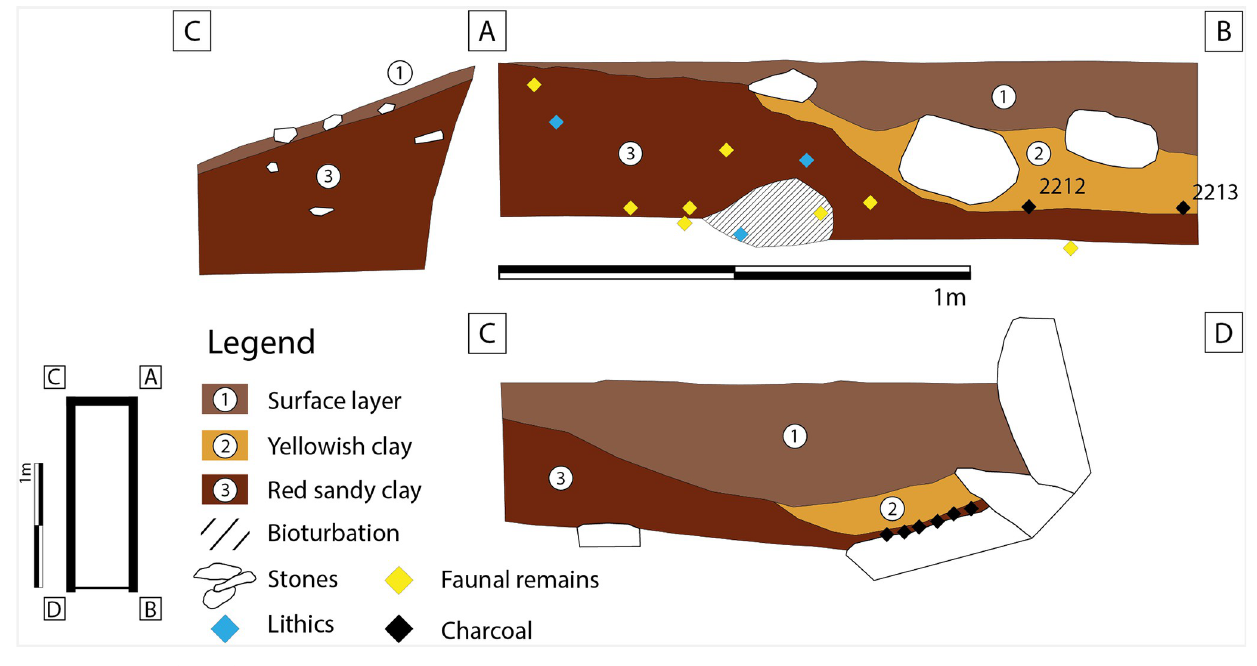
Fig 4. Excavation plan and sections: Zone